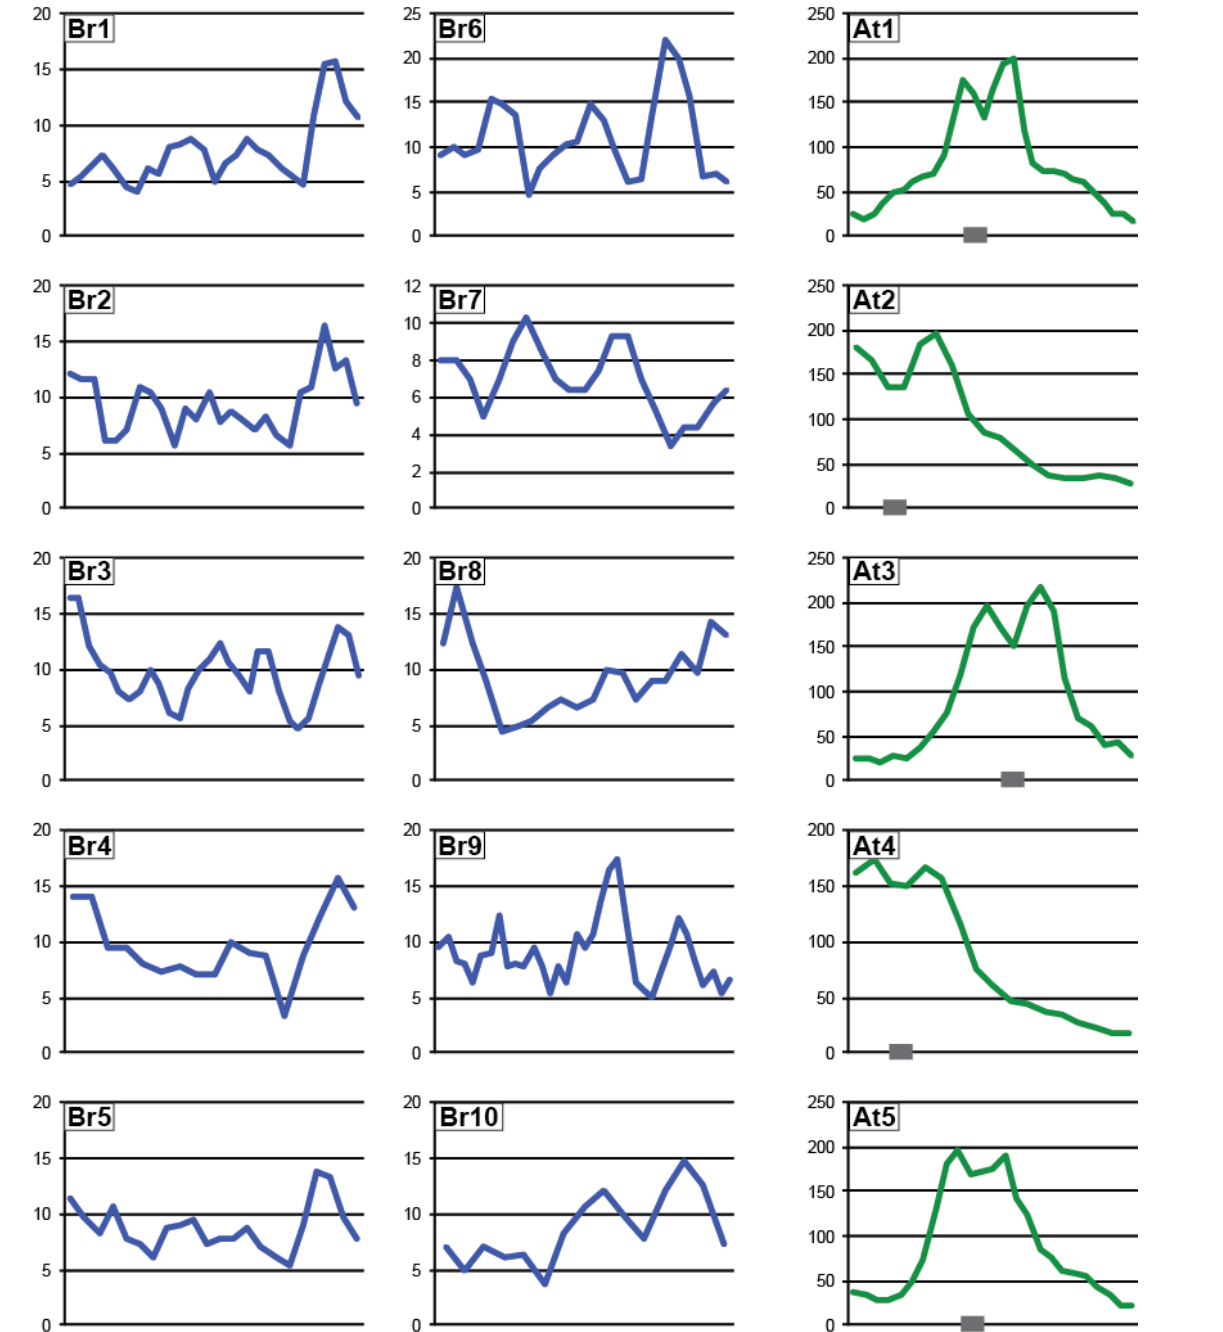
Figure 5. Chromosomal distribution of sRNA-producing loci. Number of siRNA-producing windows in a 1Mb bin (rolling average of 3 bins) across the ten B. rapa and 5 Arabidopsis chromosomes. Location of the Arabidopsis centromeres (as in [44]) are noted with grey